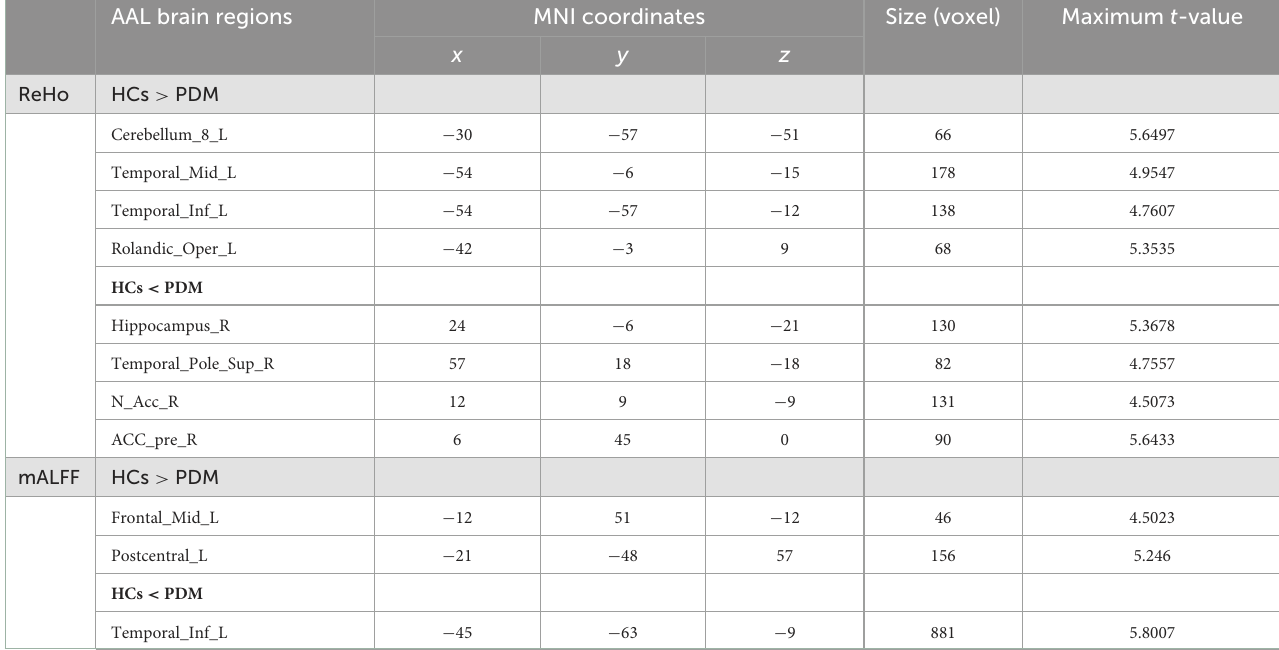
TABLE 3 Brain regions showing ReHo differences between patients with PDM and HCs (voxel threshold: uncorr. p < 0.001, cluster threshold: p -FWE < 0.05). AAL brain